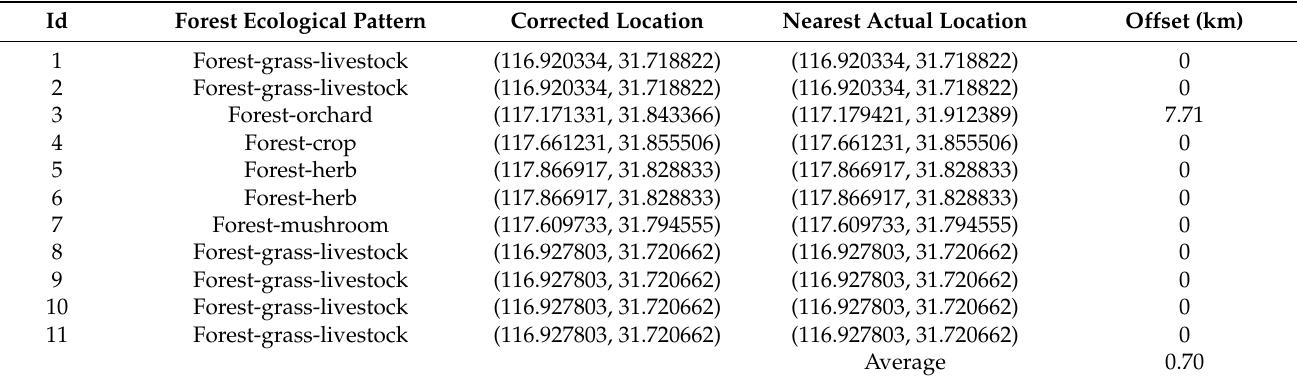
Table 4. Offset distances between the corrected locations and the nearest actual locations.